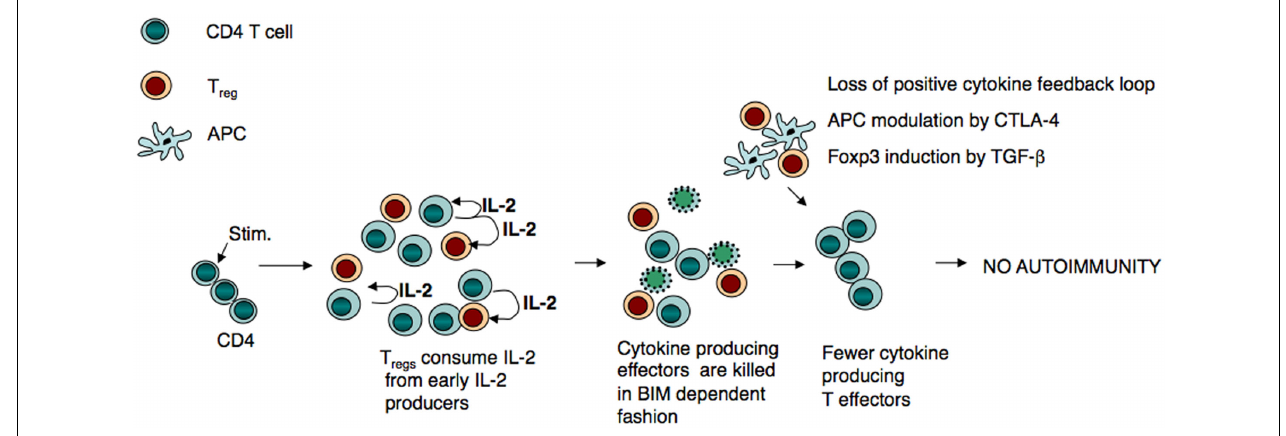
FIGURE 1 |T reg -mediated apoptosis plays a major role in limiting Th07Th1/Th2 cell responses. Under steady-state conditions, CD4 + T cells upon priming, produce IL-2 and /or other growth factors and expand responding to these cytokines. IfT regs are present during this early phase of IL-2 production, CD4 + T cells are deprived of IL-2 leading to CD4 + T-cell death.